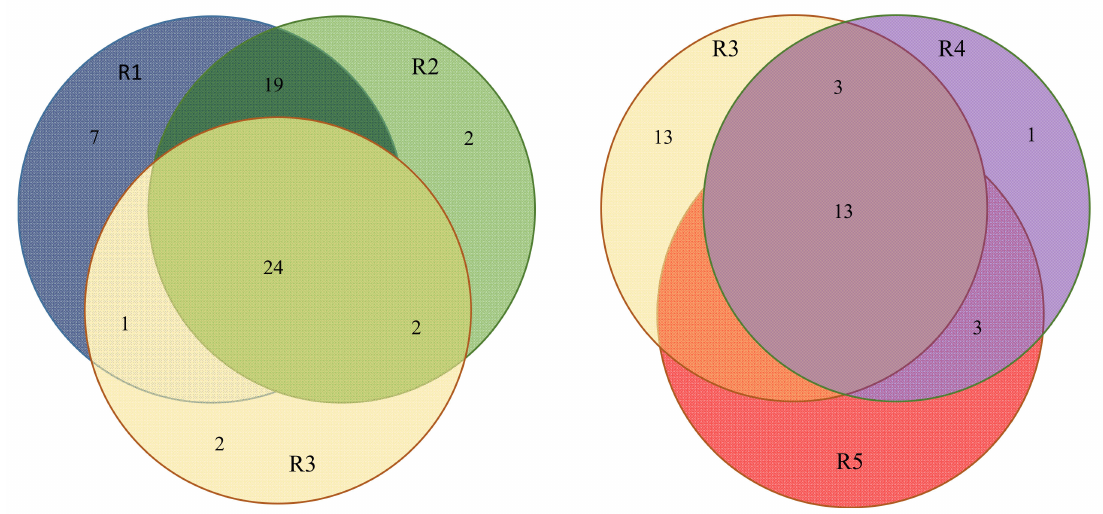
Figure 3. Venn diagrams, considering the optimum solutions (number of proteins) obtained for the 5 neutral ranges R1 to R5. The left diagram includes R1 to R3 solutions and the other includes R3 to R5.